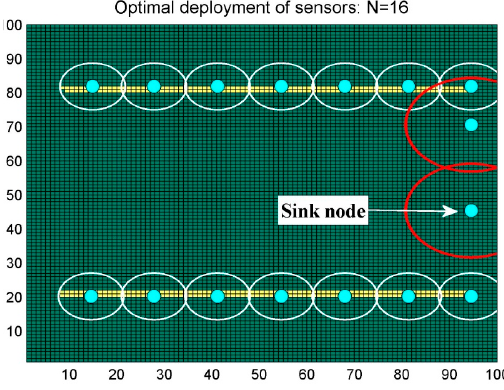
Figure 17. Optimal sensor deployment “Scenario 2”.